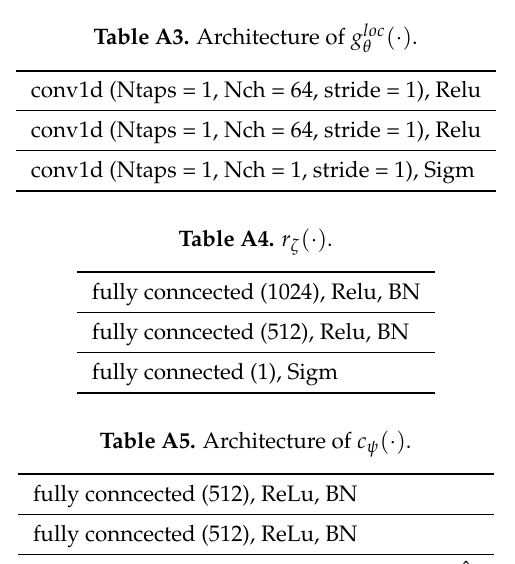
Table A3. Architecture of g loc